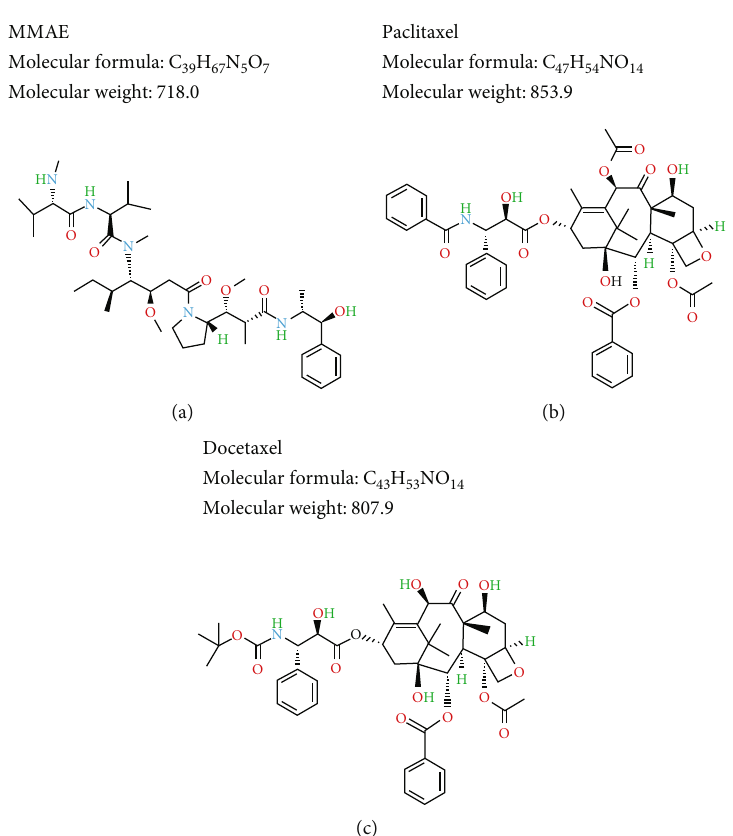
Figure 1: Two-dimensional structure of three microtubule-disrupting anticancer agents. These three agents share similar anticancer mechanisms: disrupting microtubule dynamics through the inhibition of tubulin polymerization. (a) Monomethyl auristatin E (MMAE) is a synthetic derivative of dolastatin-10 isolated from sea hare Dolabella auricularia . (b) Paclitaxel is the most well-known naturally sourced cancer drug and is derived from the bark of the Paci fi c yew tree Taxus brevifolia . (c) Docetaxel is a taxoid derived from the needles of the European yew tree Taxus baccata